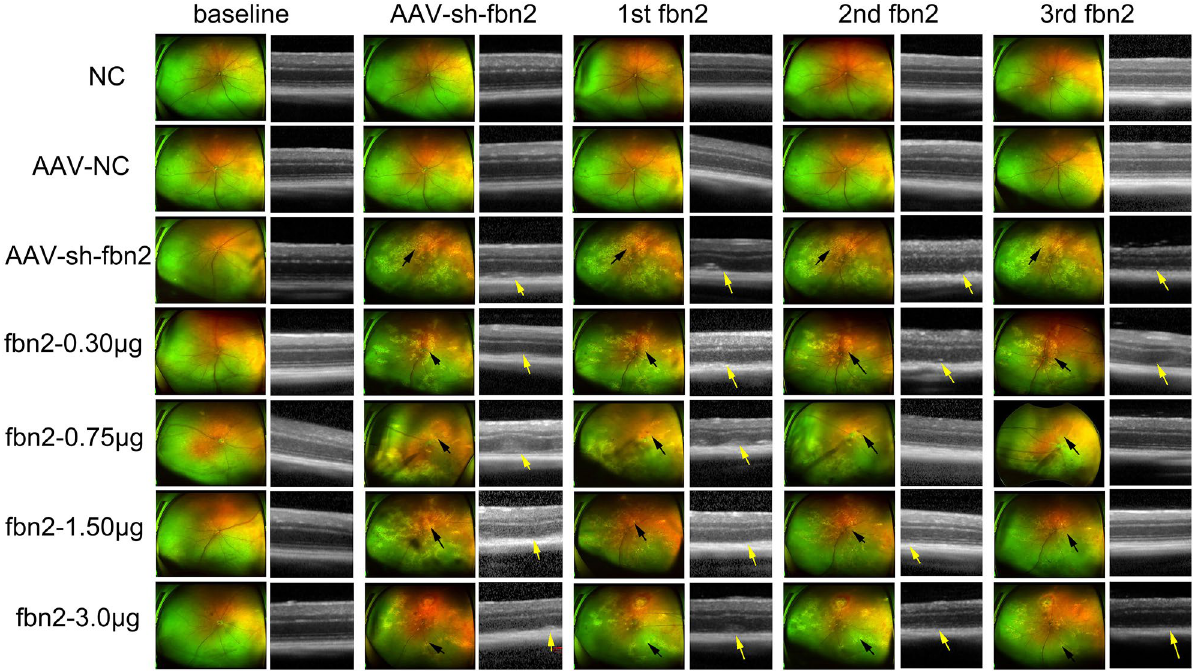
Figure 3. Fundus retinal imaging captured by SLO and OCT in NC, AAV-NC, AAV-sh-fbn2, Fbn2-0.30 μg, Fbn2-0.75 μg, Fbn2-1.50 μg and Fbn2-3.0 μg group mice. SLO showed irregular yellow-white exudates in the retina (Black arrow). OCT shows that light reflection in each layer of the retina becomes more irregular and reflectance decreases (Yellow arrow). NC group: Animals without intervention. AAV-NC group: Animals with an intravitreal injection of AAV empty vector and without any further treatment. AAV-sh-fbn2 group: Animals with an intravitreal injection of AAV-sh-fbn2 and without any further treatment. Fbn2-0.30 μg group: Animals with an intravitreal injection of AAV-sh-fbn2, followed by an intravitreal injection of fbn2 recombinant protein in a dose of 0.30 μg. Fbn2-0.75 μg group: Animals with an intravitreal injection of AAV-sh-fbn2, followed by an intravitreal injection of fbn2 recombinant protein in a dose of 0.75 μg. Fbn2-1.5 μg group: Animals with an intravitreal injection of AAV-sh-fbn2, followed by an intravitreal injection of fbn2 recombinant protein in a dose of 1.50 μg. Fbn2-3.0 μg group: Animals with an intravitreal injection of AAV-sh-fbn2, followed by an intravitreal injection of fbn2 recombinant protein in a dose of 3.00 μg.